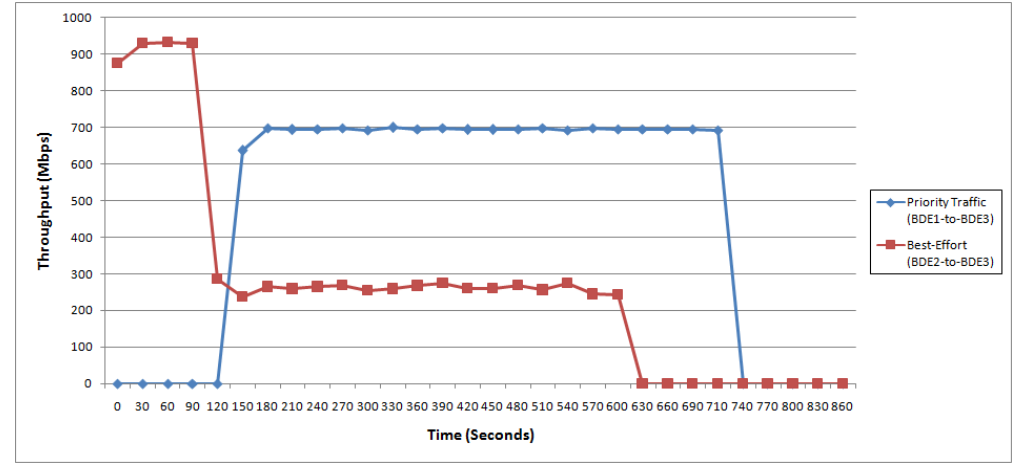
Figure 7. AmoebaNet evaluation results.